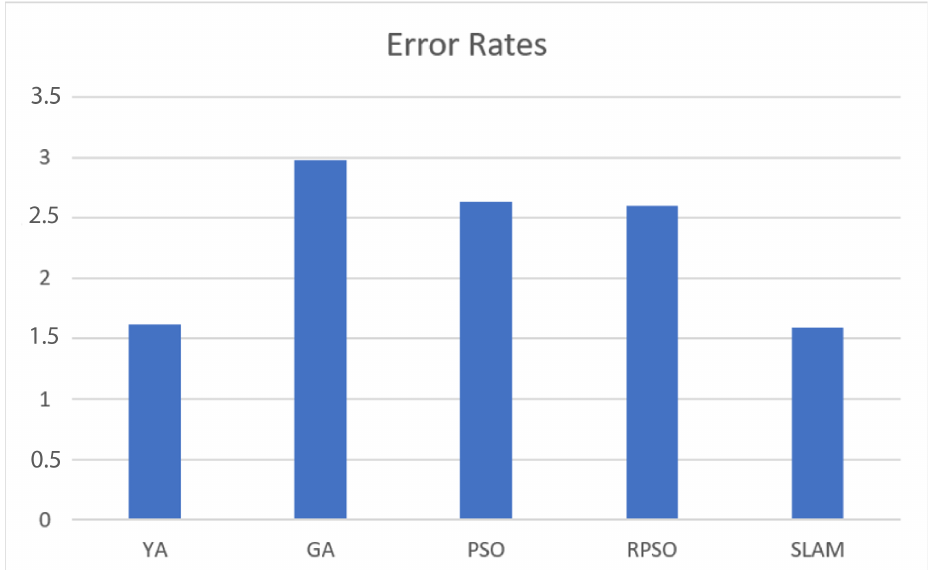
Figure 22. Average error rates for 50